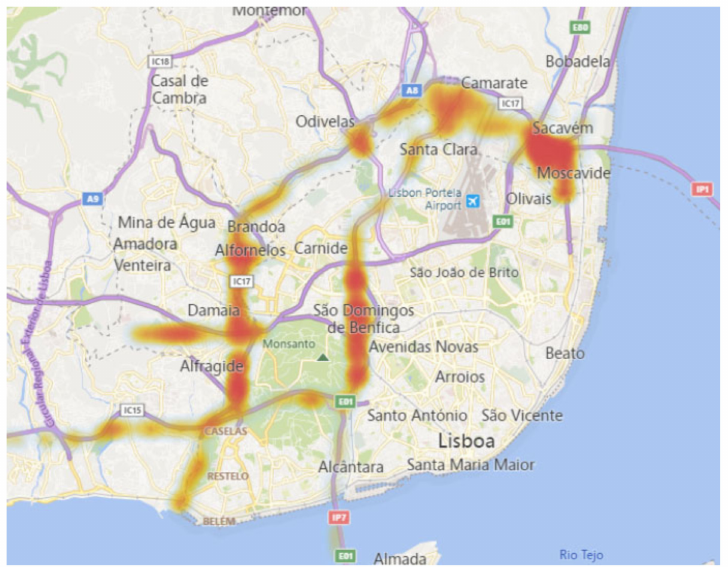
Figure 4. Distribution of traffic on freeways in Lisbon in 2019. Red corresponds to locations where more traffic congestion occurred on freeways; orange and yellow are locations where traffic congestion was less common on freeways.